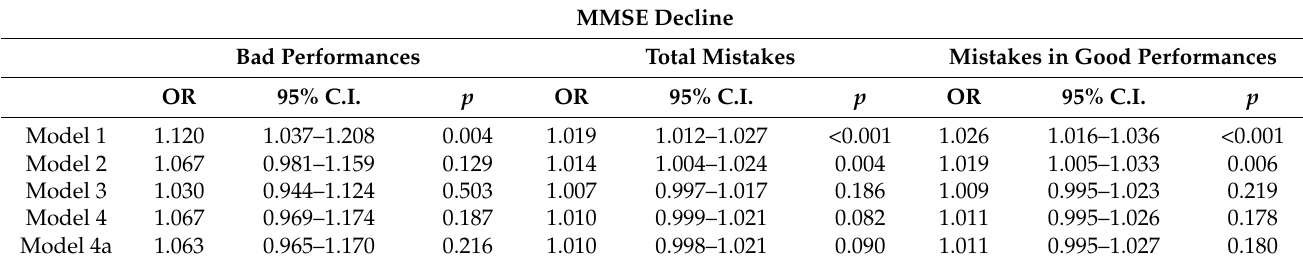
beside age ( p < 0.001, OR = 1.041, 95% C.I. = (1.025; 1.057)) and current smoking ( p = 0.020, OR = 1.491, 95% C.I. = (1.066; 2.085)), third or higher education level was significant for the outcome, specifically protective against an MMSE decline ( p = 0.043, OR = 0.738, 95% C.I. = (0.549; 0.991). Table 4. Comparison of the OR and corresponding 95% C.I. of bad performances , total mistakes, and mistakes in good performances for the prediction of MMSE decline in the binary logistic regression models. MMSE Decline Bad Performances Total Mistakes Mistakes in Good